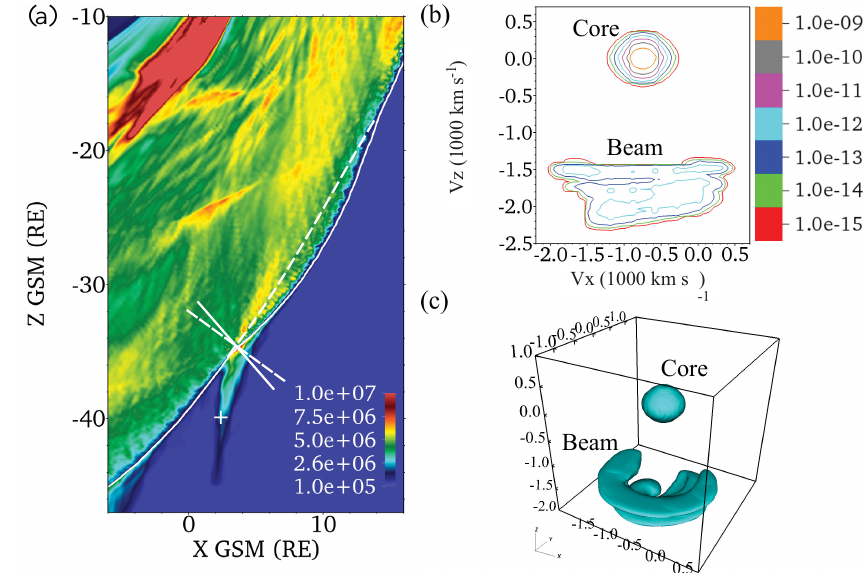
Figure 5. (a) Colour code: temperature (K) parallel to the magnetic field in a region presenting a local foreshock at 1548 . 5s simulation time. This variable is sensitive to the presence of an ion beam, hence the choice to bring out the local foreshock. The continuous white isocontour curve shows where the ion density is 2 × 10 6 m − 3 (twice the solar wind density), thus indicating the bow shock location. The dashed white curve would show the approximate position of the bow shock were it not for the increased pressure due to a fast wave front in the magnetosheath. The continuous and dashed segments indicate the normal direction for each of these curves. θ B − n : 41 ◦ and 54 ◦ ; thus the angle between both is 13 ◦ . (b) Two-dimensional projected isocontour and (c) three-dimensional isocontour plots of the ion velocity distribution (phase space density in s 3 m − 6 ; 3-D isocontour at 1 × 10 − 15 s 3 m − 6 ) at the location of the white cross. The field-aligned beam is prominent and directly comparable to Figs. 2 and 6 in the work by Kempf et al.